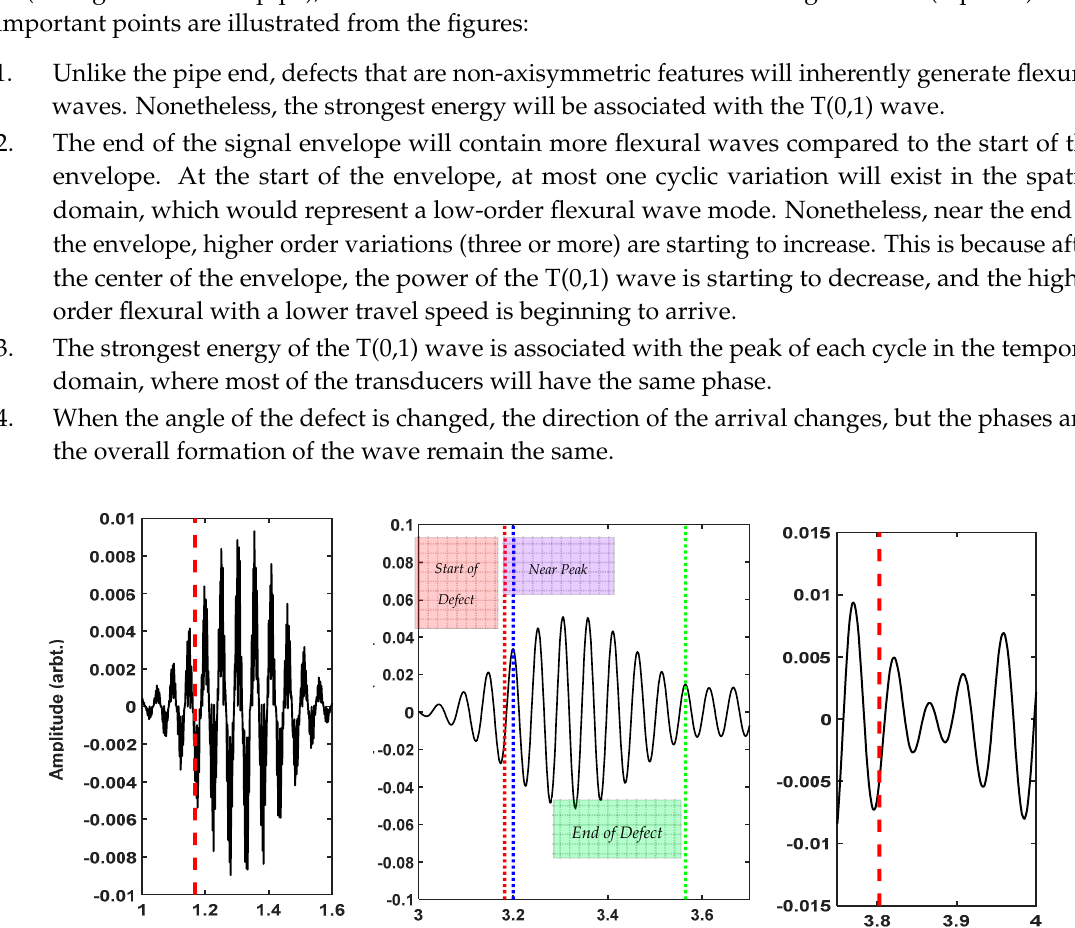
Figure 2. Temporal domain of cases (d)–(i) from Figure 1 .